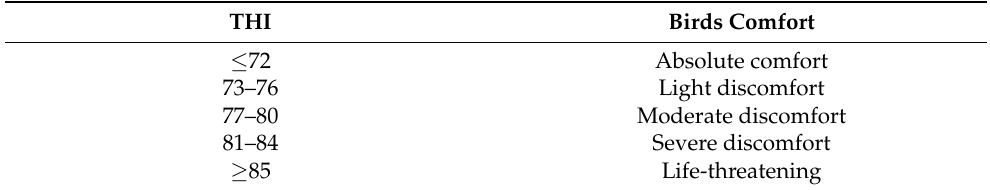
Table 3. Broiler comfort levels under different THI.